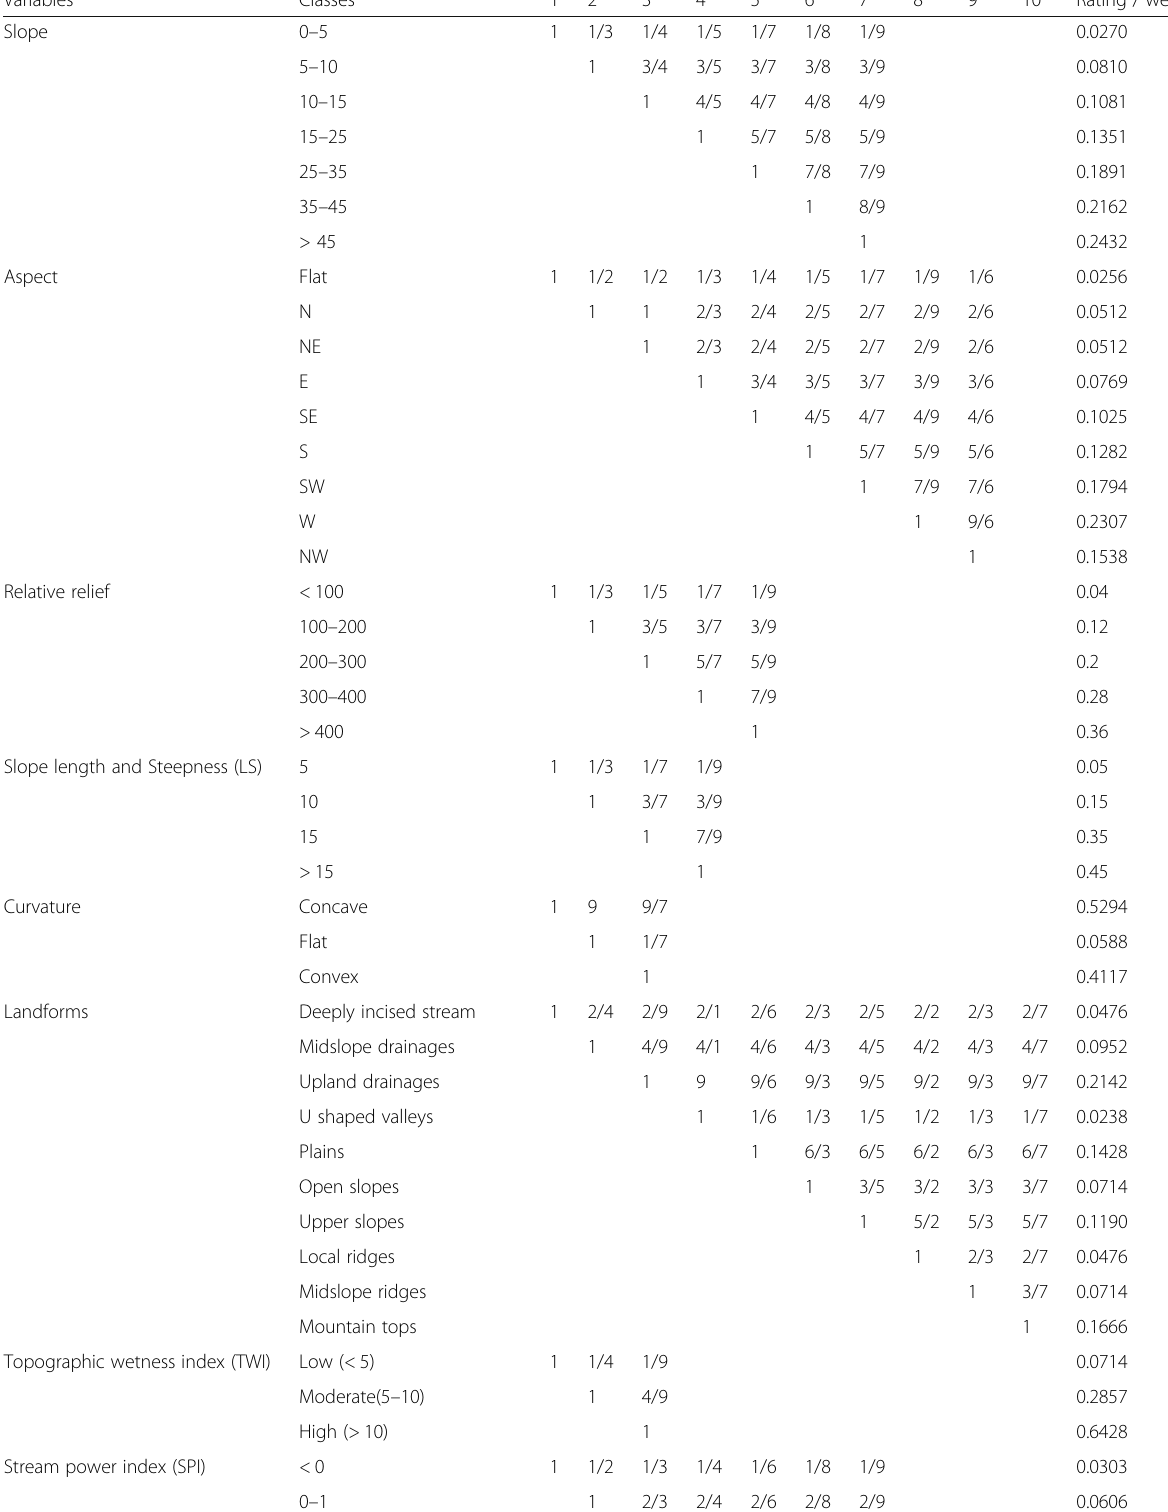
Table 1 Pair-wise comparison matrix, ratings, and consistency ratio of the variables classes and individual variables used in the present study